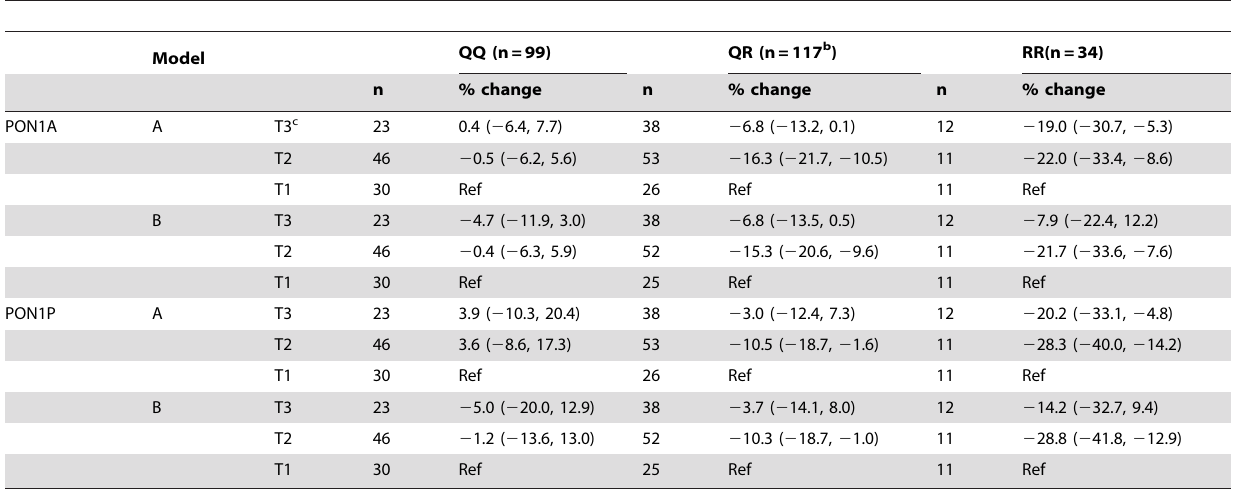
a Composite tertiles definitions: high (in highest tertile of at least two metals), low (in lowest tertile of at least two metals), medium (else). b There were only 115 women with diet information available for the adjusted models. c T3: Highest, T2: Middle, T1: Lowest. A: unadjusted. B: adjusted for age (continuous), race (white, black, Asian, other), BMI (continuous), smoking (current, no), leafy green servings (continuous), fish servings (continuous), shellfish servings (continuous), concurrent metal levels (tertiles).